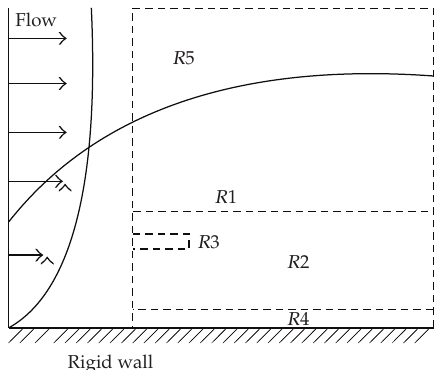
Figure 1: Schematic sketch of flow structure showing the multilayered nature of the boundary layer and the relative positioning of the five